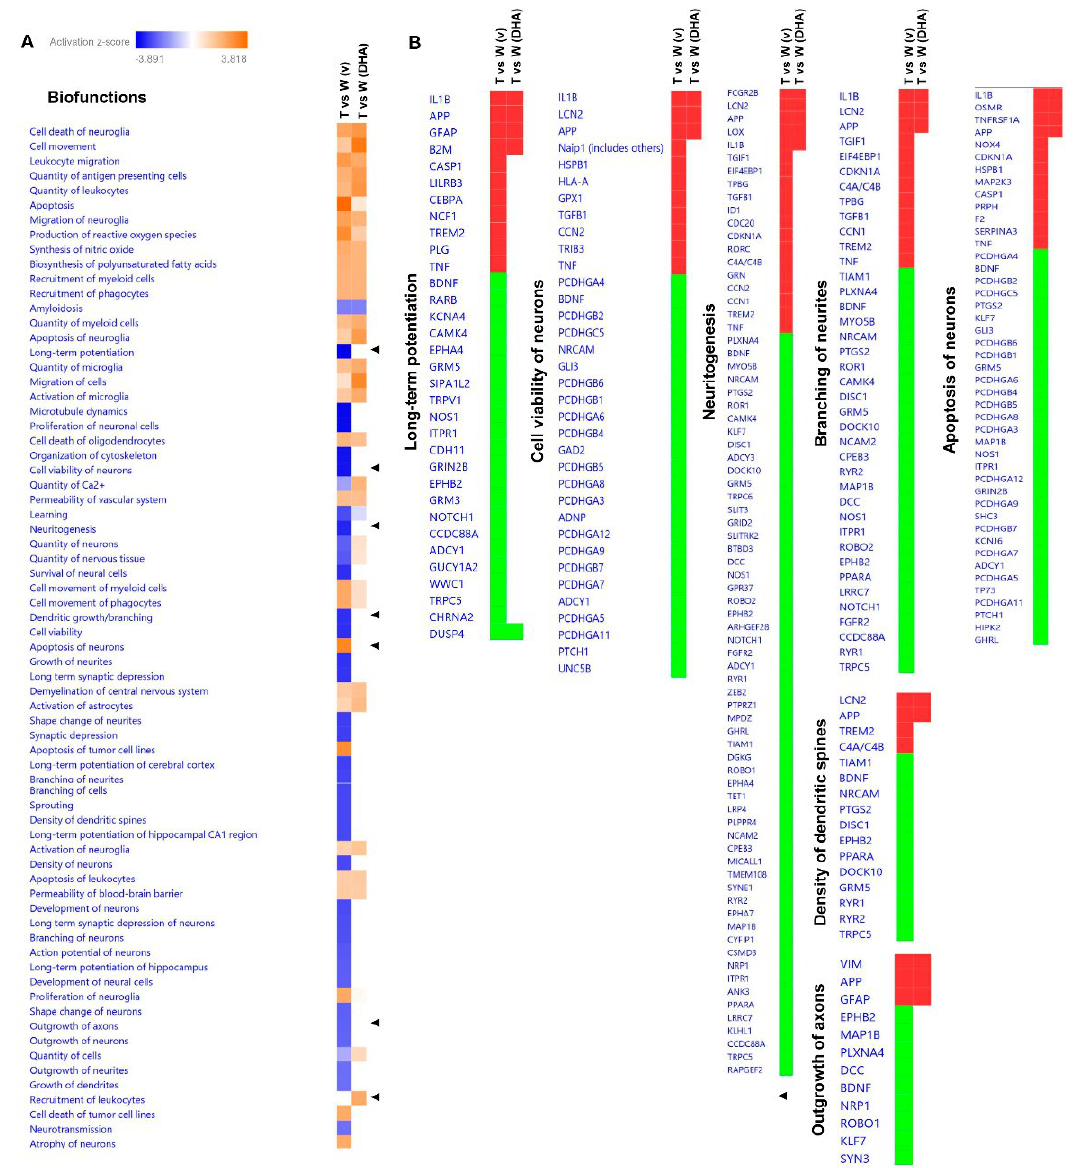
Figure 5. Predictive activation profile of neuronal functions upon DHA treatment. Systems biology analyses were performed using IPA software to generate the activation prediction of significantly altered neuronal functions ( A ). Blue and orange squares indicate inhibition and activation direction- ality, respectively. Black triangles refer to specific functions whose restoration is associated to DHA treatment ( B ). T: Tg2576, W: wildtype, v: vehicle. Red: up-regulation; green: down-regulation.